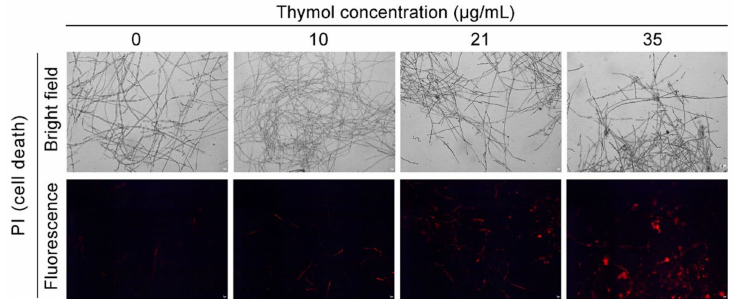
Figure 4. PI-indicated cell death in the mycelia of FON upon thymol treatment. The mycelia were treatment with thymol (0, 10, 21, and 35 µ g/mL) for 24 h, followed by incubation with PI and fluorescent